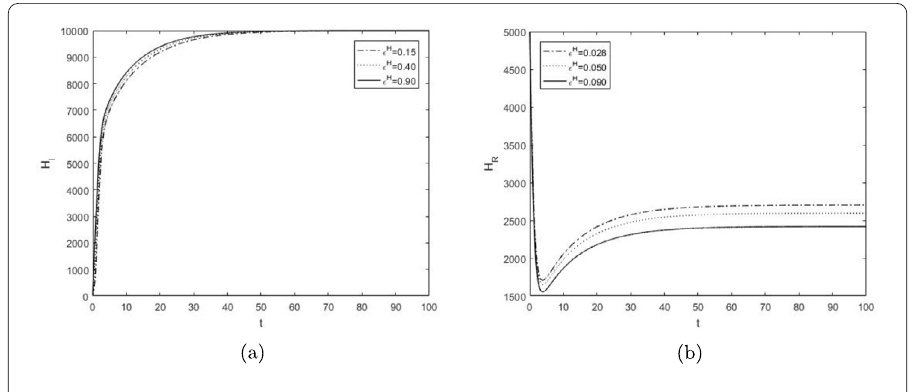
Figure 8 Variation of H I , H R versus t for (cid:6) H =